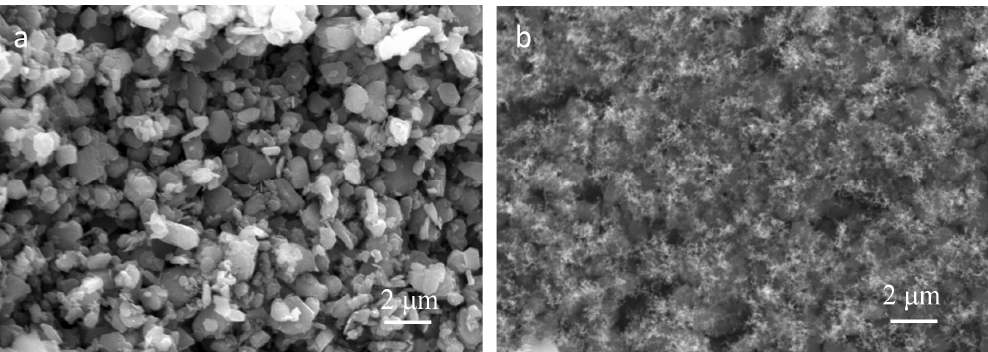
Figure 7. SEM micrographs of surface char residue of ( a ) PE / ATH and ( b ) PE / ATH / GNP after Cone testing.